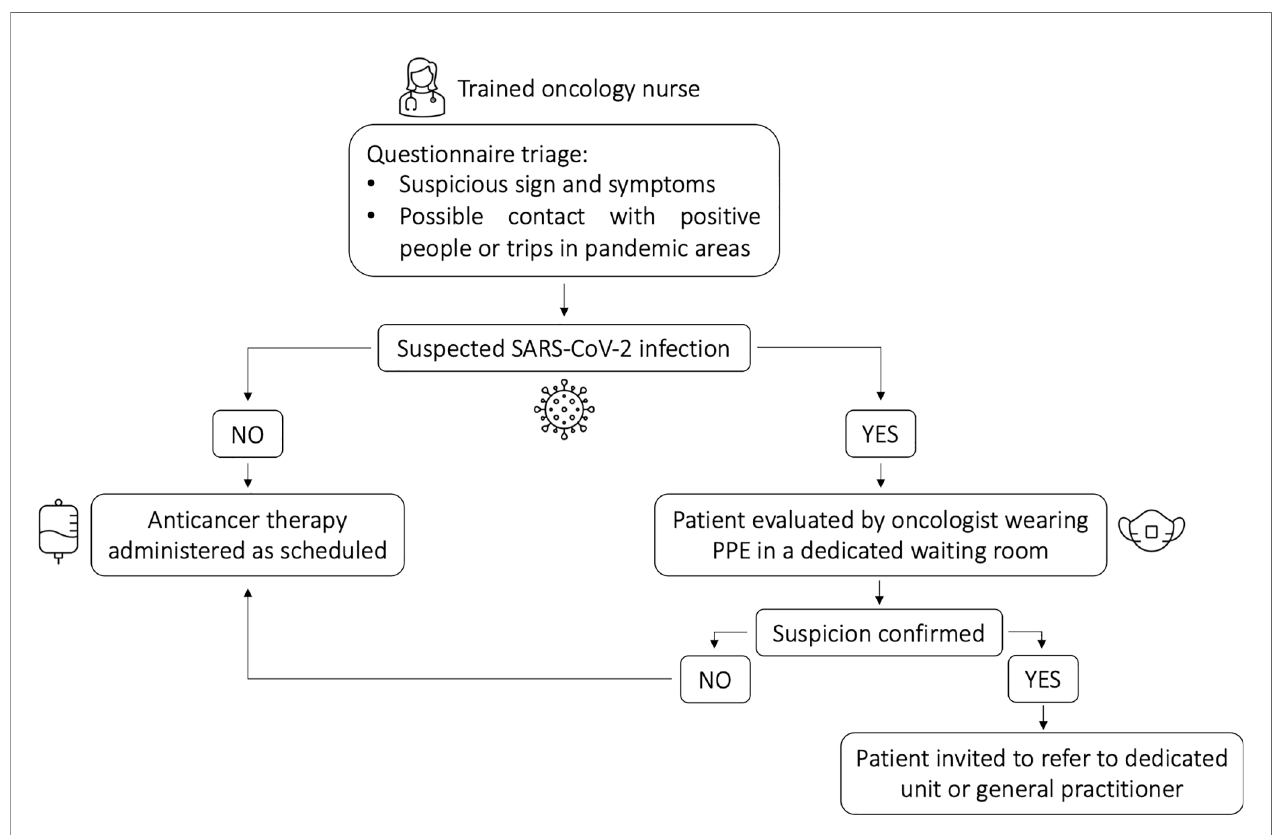
FIGURE 1 | Patient pathway following triage